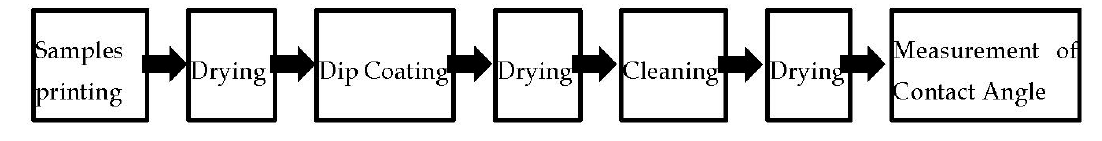
Figure 4. Schematic image of samples preparation.